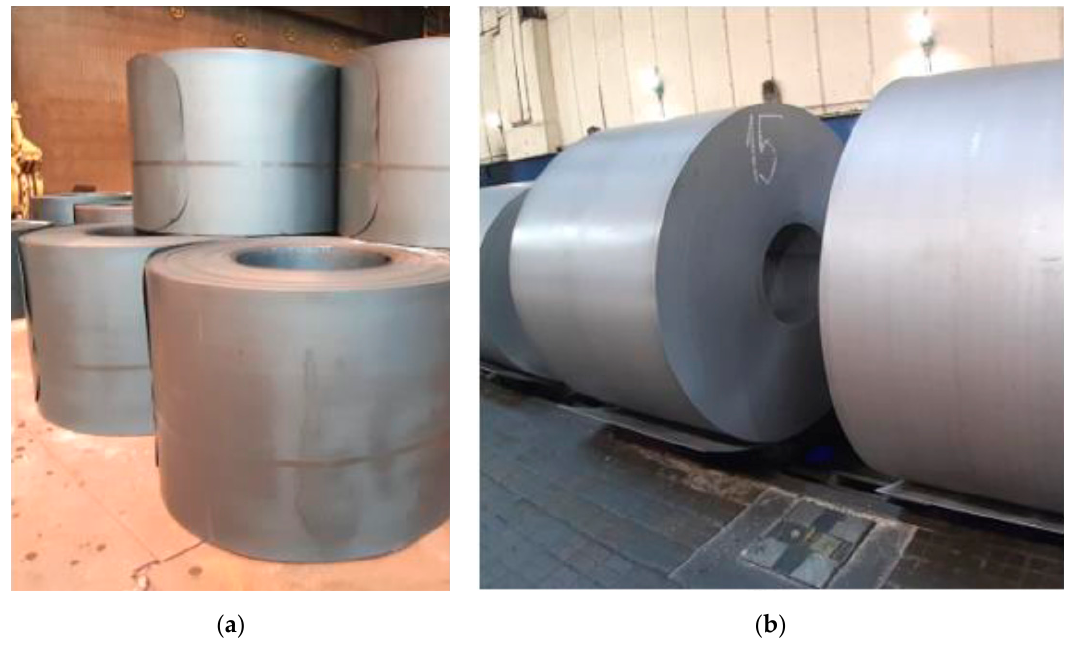
Figure 2. ( a ) Hot-rolled coils before pickling process; ( b ) Coils after pickling process.